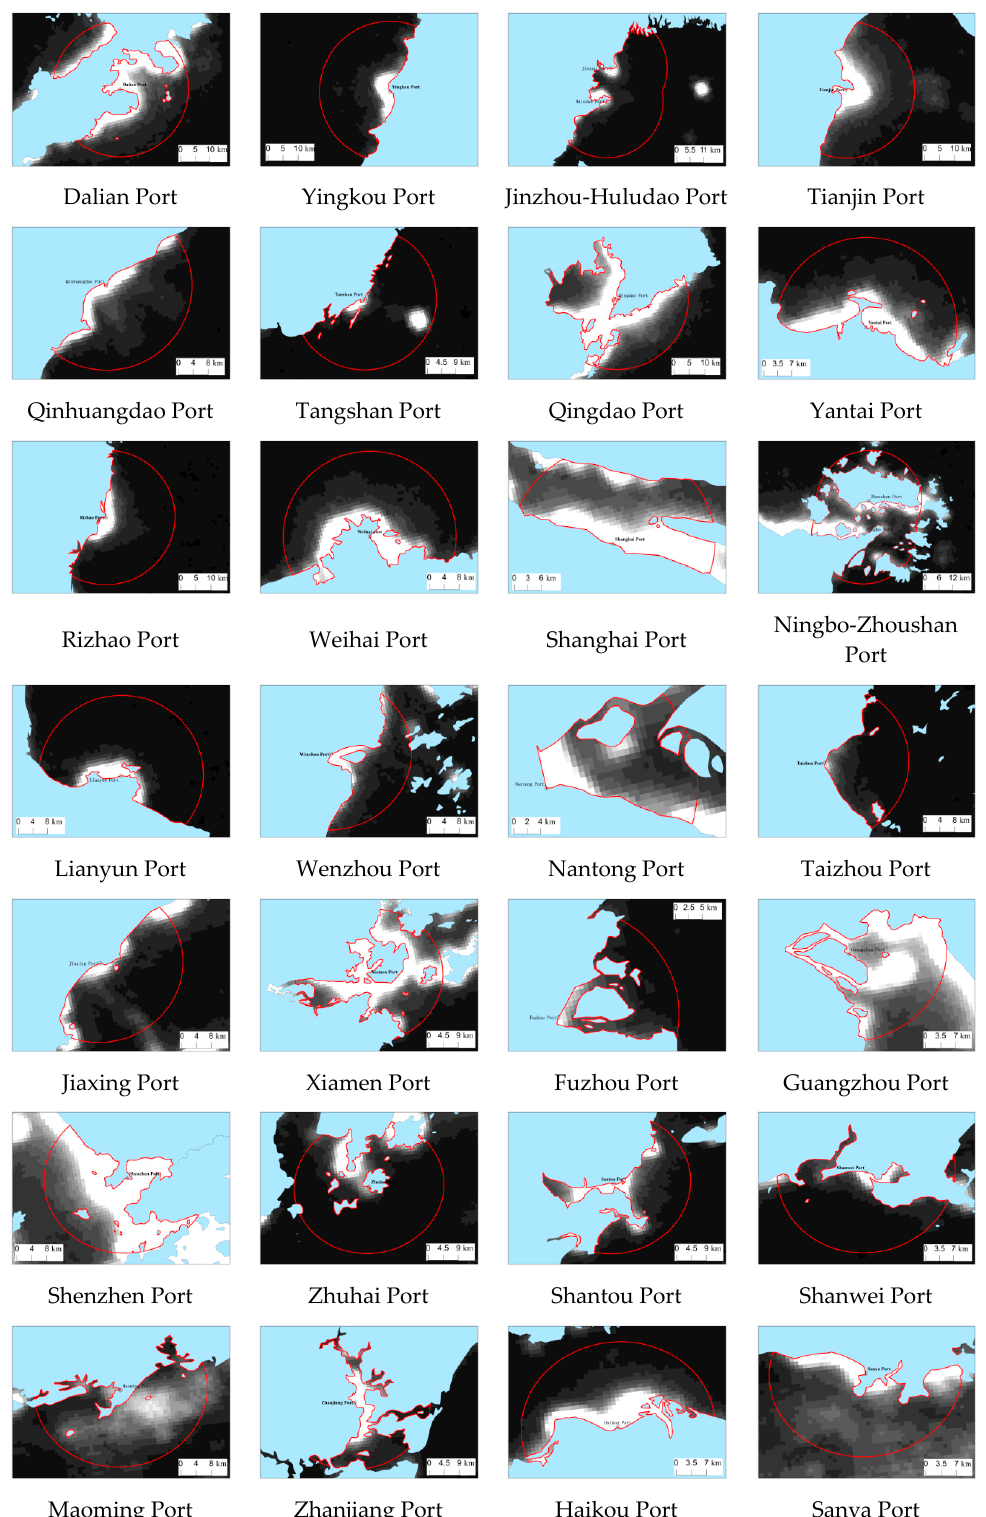
Figure 4. Light collection range of coastal ports.